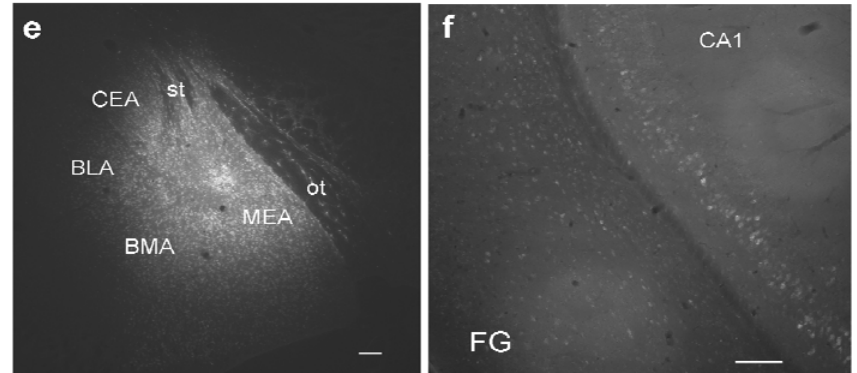
Figure 1. Study design and distribution of retrogradely labeled GABA neurons in the ventral hippocampus. ( a ) Schematic diagram of intersections of retrogradely labeled neurons, GABAergic neurons, and GABAergic markers in the ventral hippocampus; ( b ) typical site of pressure injection into the amygdala (case #382; see Table 1) at the site of maximal width. Cortical areas, e.g. the piriform cortex are largely spared; ( c ) Distribution of retrograde FG-labeling in the ventral hippocampus (#382). Labeling in the hippocampus is confined mainly to the pyramidal layer of CA1 and ventral subiculum (VS). Additional labeling is seen in the perirhinal cortex (PrhC), the amygdalo-piriform transition area, and the medial geniculate body (MGB). Rather sparse labeling is found in the entorhinal cortex (EC) and the posteromedial cortical nucleus of the amygdala (PMCo). Molecular layers of CA1 and VS and entire CA3 and DG regions are devoid of retrogradely labeled neurons; ( d ) Distribution of GFP-positive neurons in the same section; ( e ) maximal distribution of FG after an iontophoretic injection into the medial amygdala (MEA). Note the circular necrotic core (location of the needle tip) and the circular halo around the core, which is considered the active uptake zone. Beyond the halo is a circular diffusion zone. Note that the central nucleus (CEA), the basolateral nucleus (BLA), and the basomedial nucleus (BMA) are not reached by the halo but only by the diffusion zone. The optic tract (ot) medial to the injection limited the circular diffusion of tracer; ( f ) Retrograde labeling pattern after the iontophoretic injection seen in ( e ). Calibration bars = 1mm ( b ); 500 μ m ( c , d ); 100 μ m ( e , f